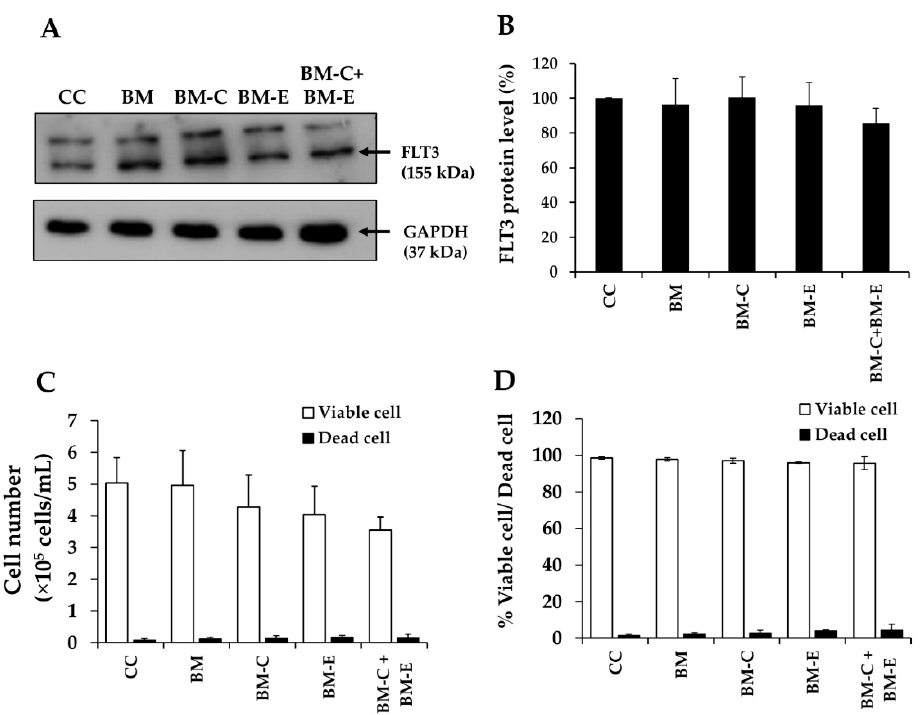
Figure 14. Effects of BM and BM conjugated FLT3 peptides on KG-1a cells. ( A ) FLT3 protein bands, ( B ) percentage of FLT3 protein expression level, ( C ) cell number, and ( D ) cell viability of KG-1a cells after treatment with media (CC, BM, BM-CKR (BM-C), BM-EVQ (BM-E), and BM-CKR+BM-EVQ (BM-C+BM-E)) for 48 h.